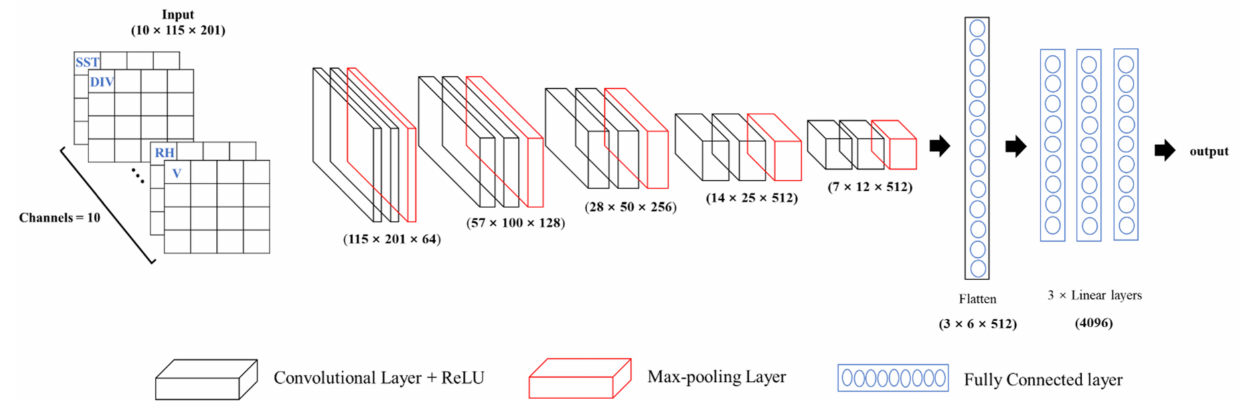
Figure 2. The architecture of VGG-16s.